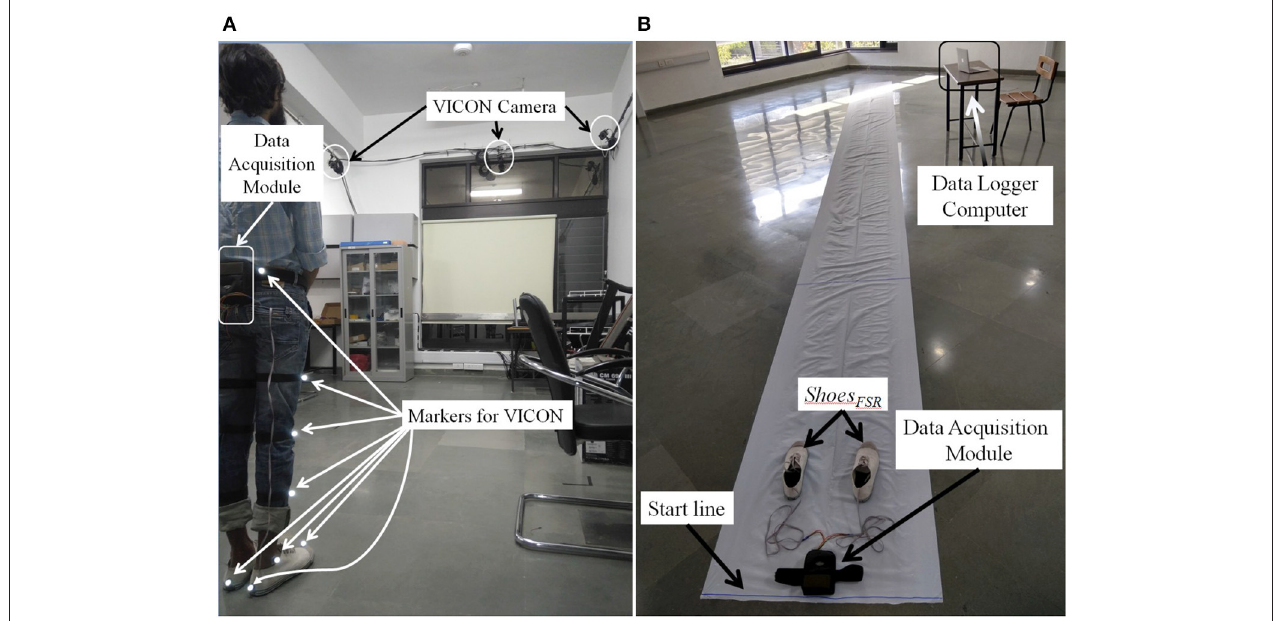
FIGURE 5 | Walk path (A) with VICON cameras for Stage 1; (B) for Stages 2 and 3.